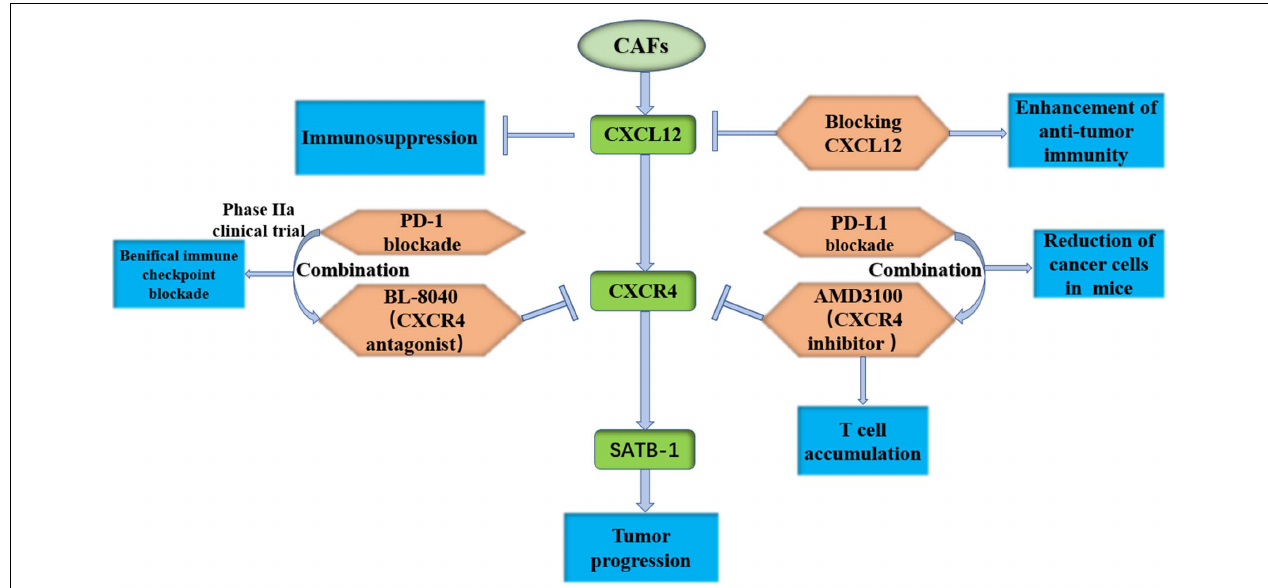
FIGURE 5 | Target the CXCL12-CXCR4 axis is effective in preclinical study. CAFs, cancer-associated fibroblasts; CXCR12, C-X-C motif chemokine receptor 12; CXCR4, C-X-C motif chemokine receptor 4; SATB-1, special AT-rich sequence binding protein 1; PD-1, programmed death 1.